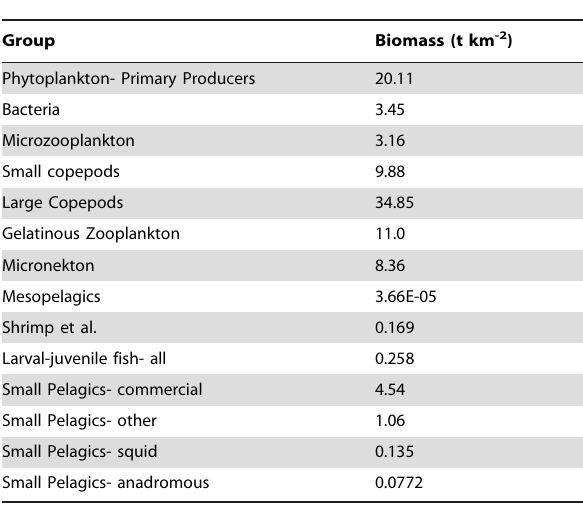
Table 2. Major functional groups of pelagic species in the Gulf of Maine and standing stock biomass estimates.